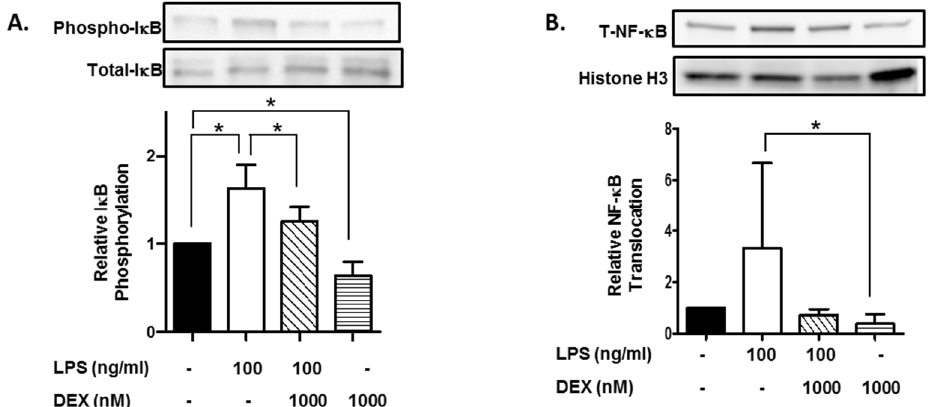
Figure 2. Effect of DEX on LPS-induced IκB activation and translocation of NF-κB. HMC3 cells were incubated with 1000 nM DEX for 30 min and further incubated with or without 100 ng/mL LPS for 15 min. Thereafter, the phosphorylation of IκB ( A ) and translocation of NF-κB ( B ) were analyzed by Western blotting. Phosphorylated IκB was normalized with total IκB and expressed as a ratio to that of LPS-stimulated HMC3 cells without DEX ( A ). Translocation of NF-κB was normalized with histone H3, and expressed as a ratio to that of LPS-stimulated HMC3 cells without DEX ( B ). Representative images of Western blotting are shown, above the graphs. Data are the means ± SD of 3 separate experiments. Data are compared between without and with LPS in the absence of DEX, between without and with DEX in the absence of LPS, and between without and with DEX in the presence of LPS. * p < 0.05.